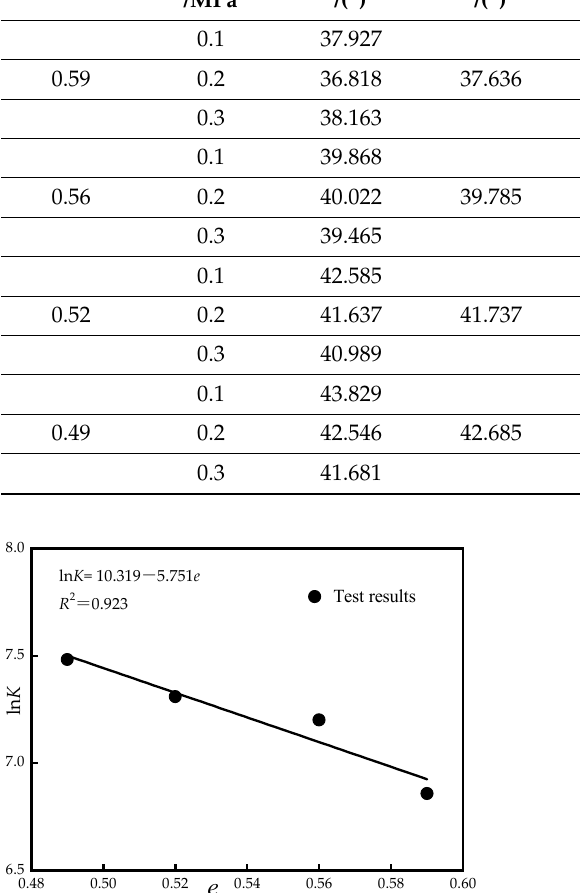
Figure 4. Relationship between K and e .